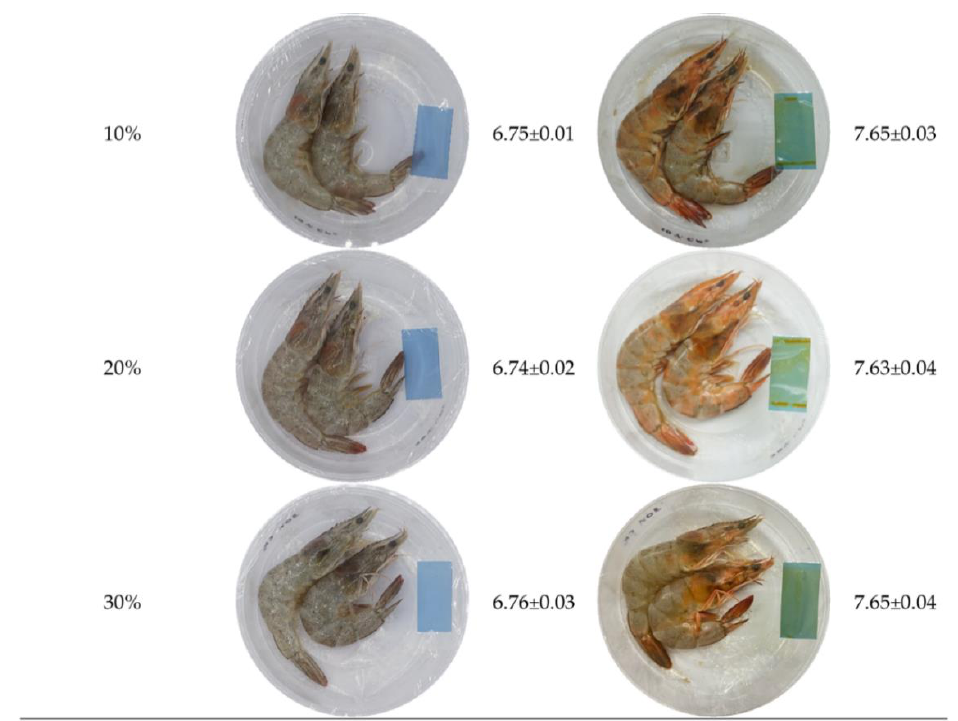
Figure 3. Application of a cellulose nanosphere (CNs)-containing smart bilayer film for monitoring changes in shrimp quality at 25